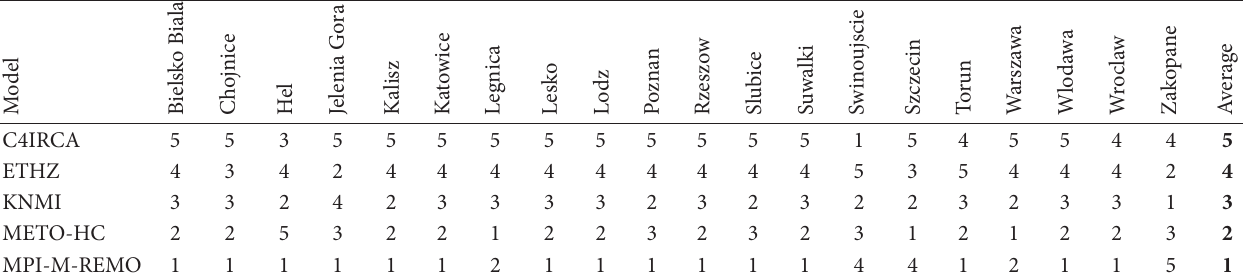
Table 4: Verification of models for precipitation. The final ranks of models for all the stations and the mean ranks for